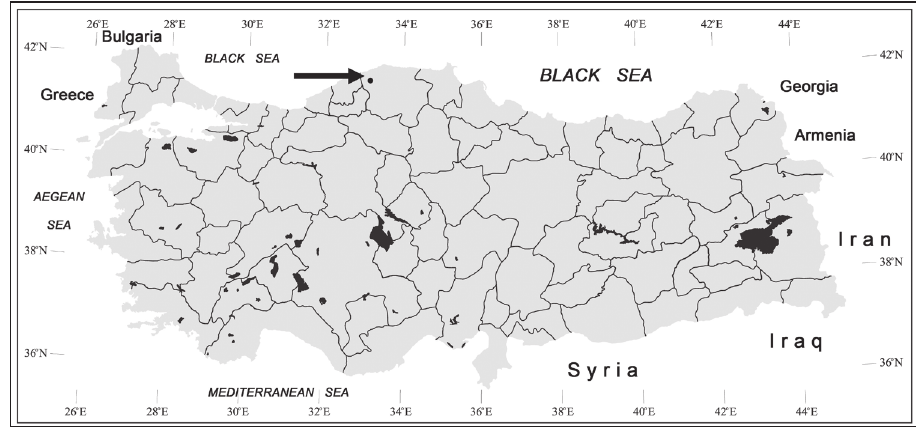
Figure 17. Administrative map of Turkey with black arrow and dot marking approximately the type locality of Beronaphaenops gen. n. paphlagonicus sp.